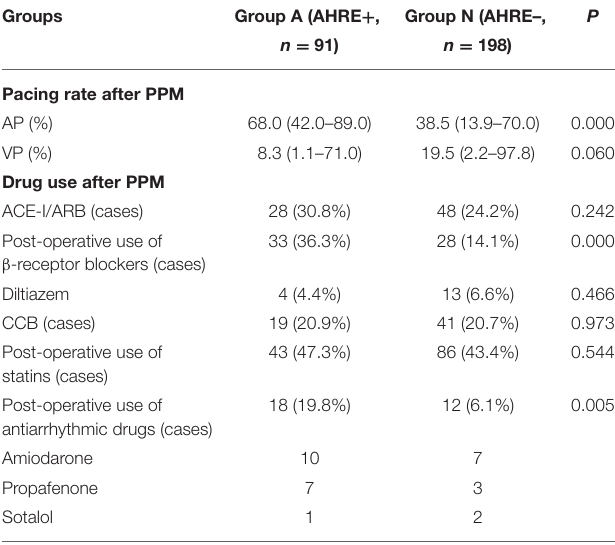
TABLE 2 | Comparison of post-operative data between two groups after PPM.